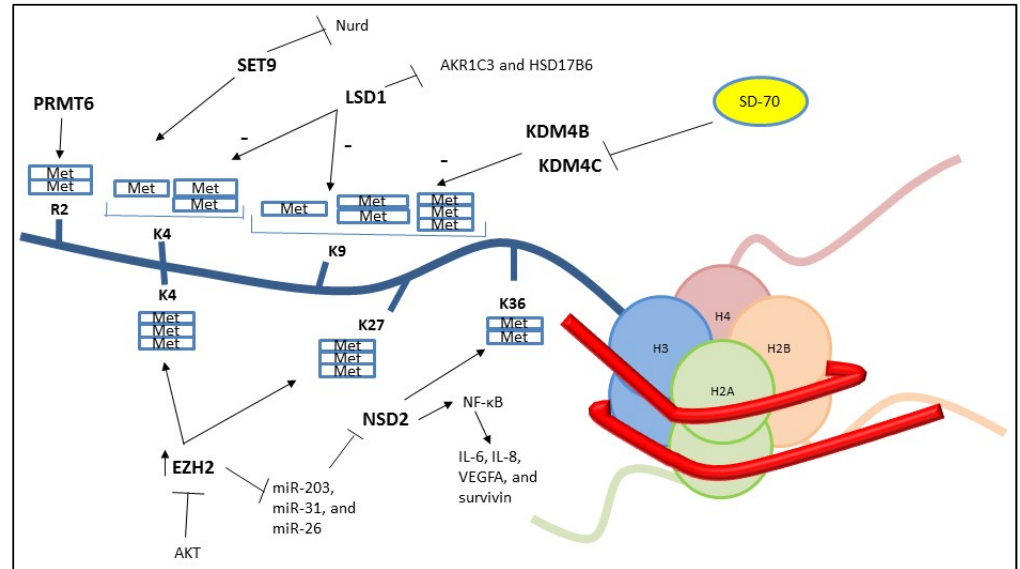
Figure 1. Schematic overview of AR histone 3 methylation status. SD70 inhibits the demethylase activity of KDM4C and is effective in CRPC cells both in vitro and in vivo. NURD: nucleosome remodeling deacetylase complex; EZH2: enhancer of zeste homolog 2; LSD1: lysine specific demethylase 1; NSD2: nuclear receptor-binding SET domain-protein 2; PRMT6: protein arginine methyltransferase 6; KDM4B and KDM4C: Lysine Demethylase 4B and 4C.